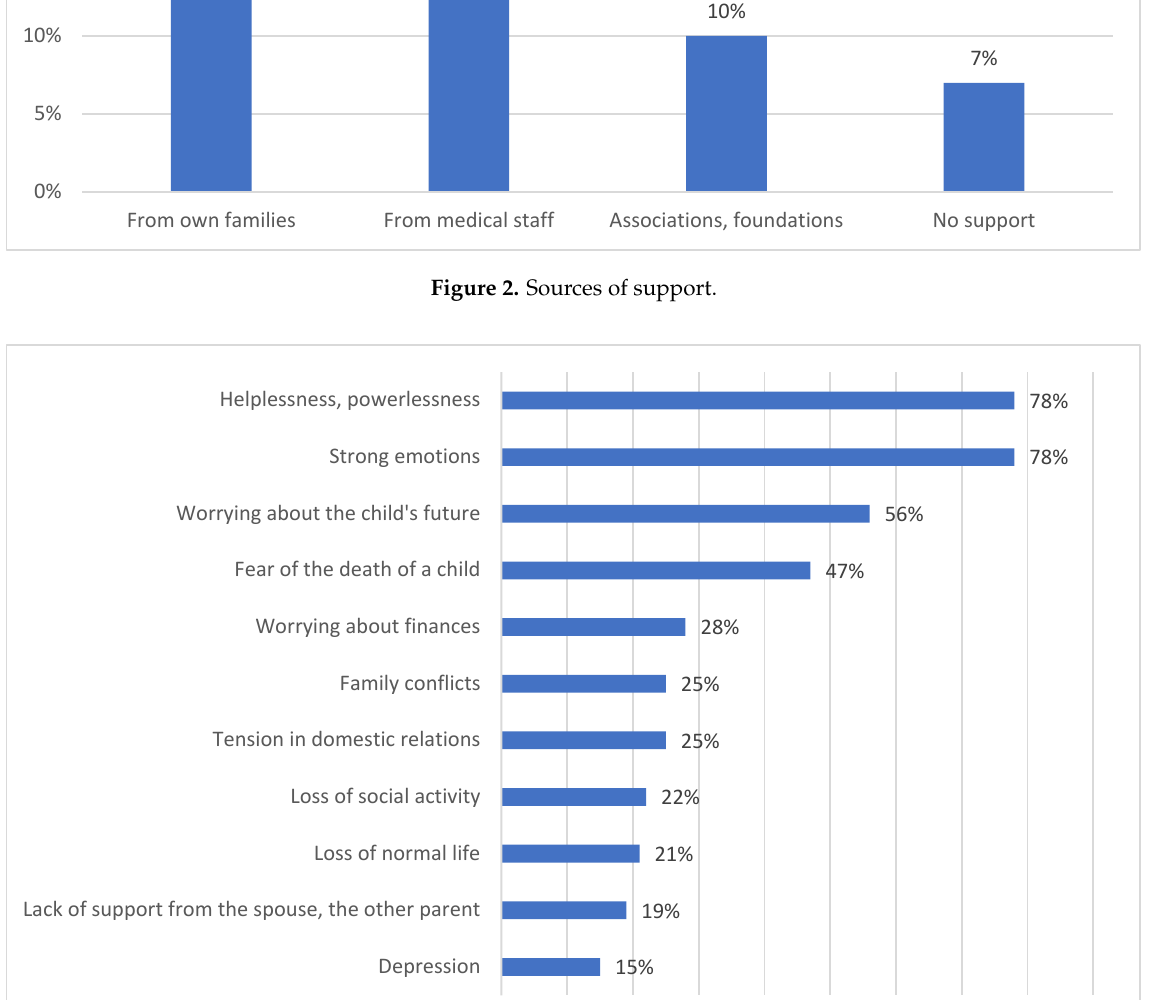
Table 3. Symptoms checklist. Symptoms